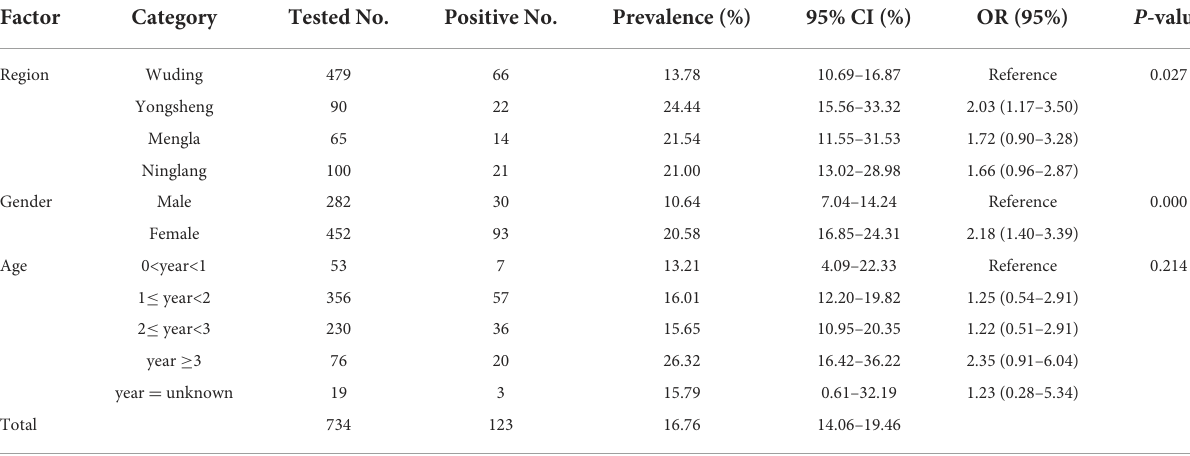
TABLE 1 Seroprevalence of Toxoplasma gondii in black goats in Yunnan Province, Southwestern China. Factor Category